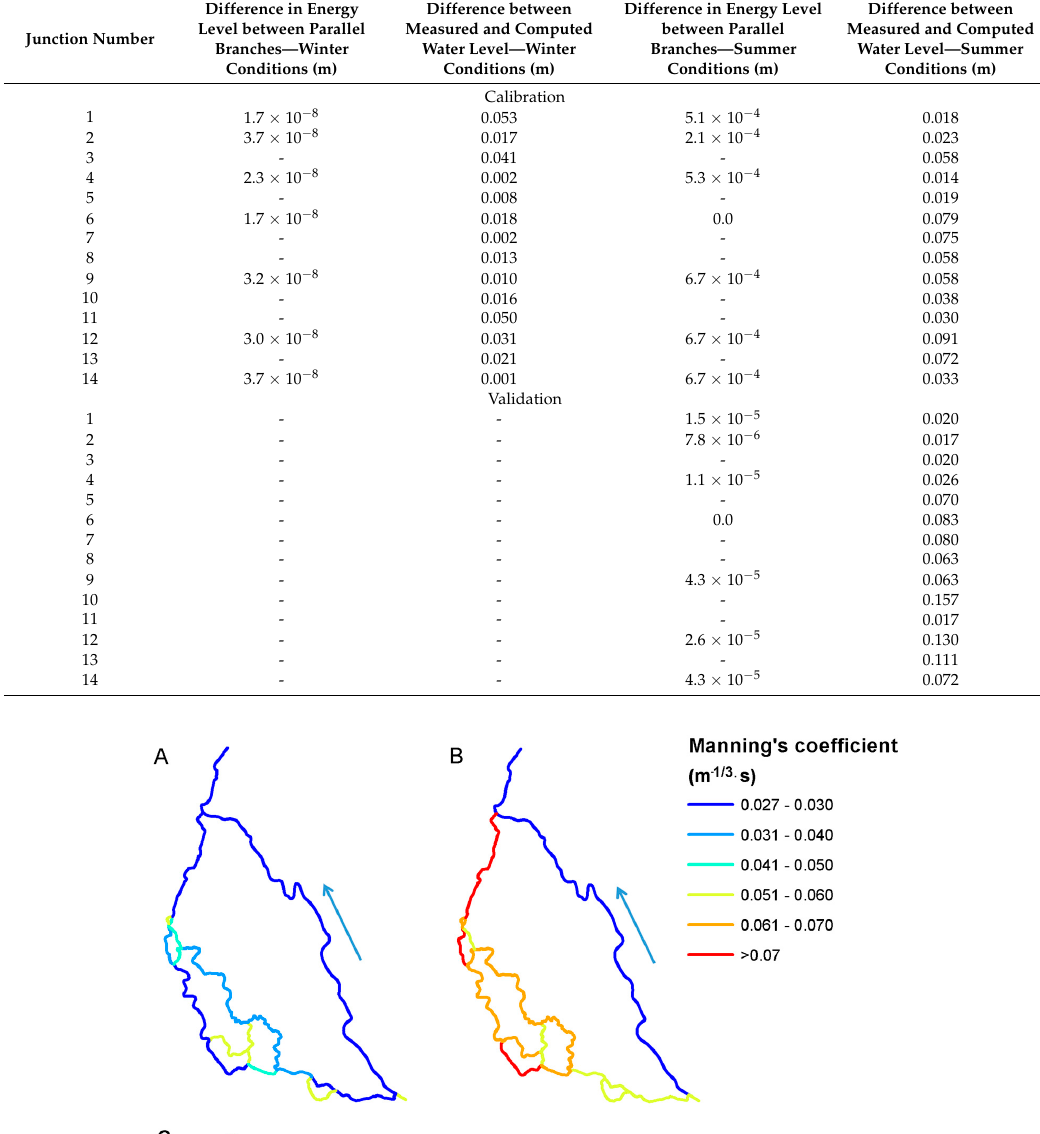
Junction Number